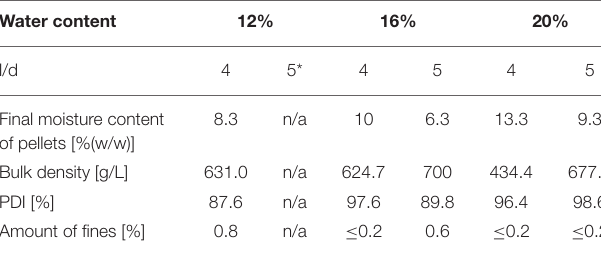
TABLE 3 | Characteristics of produced pellets with different dies and from feedstocks with different initial moisture